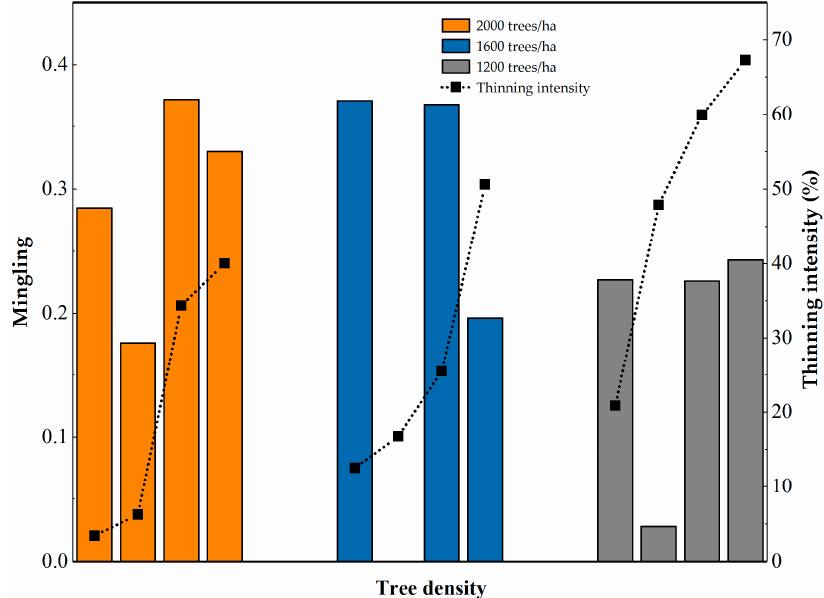
Figure 4. The effect of thinning on mingling under a different stand density.